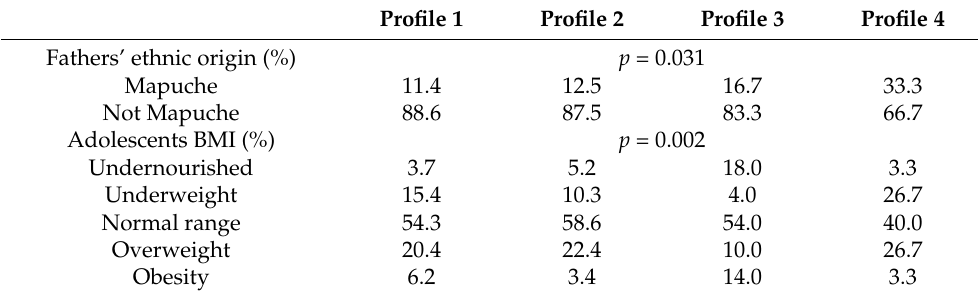
Table 5. Differences (%) of the satisfied between the four latent profiles according to fathers’ ethnic origin and body mass indexes (BMI) of